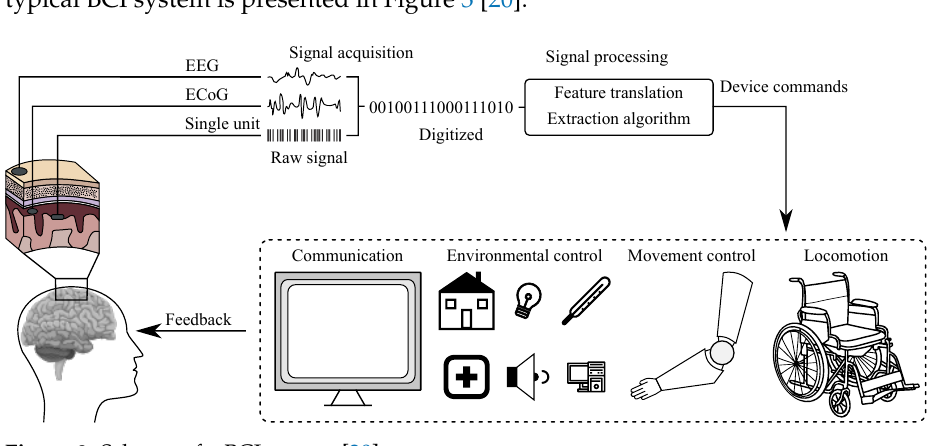
Figure 3. Scheme of a BCI system